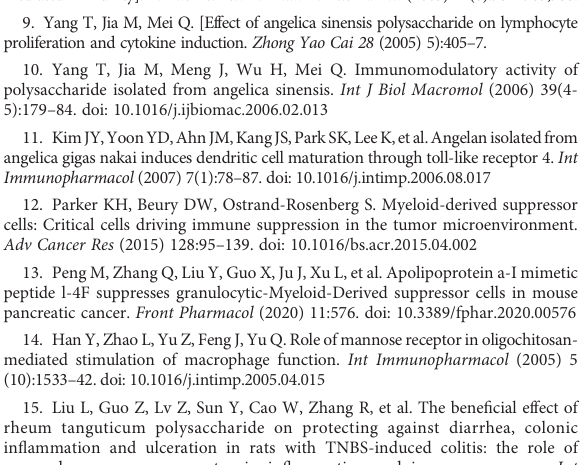
SUPPLEMENTARY FIGURE Expression of MR (CD206) on MDSC and BMC. (A, C, E, G, I, K) One representative result from each experiment is shown. M-MDSC were gated by CD11b + Ly6C +/high Ly6G - cells and PMN-MDSC were gated by CD11b + Ly6C low Ly6G + cells. The percentages of MR + (CD206 + ) cells among the M-MDSC (B) and PMN-MDSC (D) isolated from normal mouse. The percentages of MR + (CD206 + ) cells among the M-MDSC (F) and PMN-MDSC (H) induced in vitro . The percentages of MR + (CD206 + ) cells among the BMC which were isolated from normal mouse (in day 0) (J) , The percentages of MR + (CD206 + ) cells among the BMC which were cultured with recombinant mouse GM-CSF in day 4 (L) . n=10, Data are expressed by mean ±